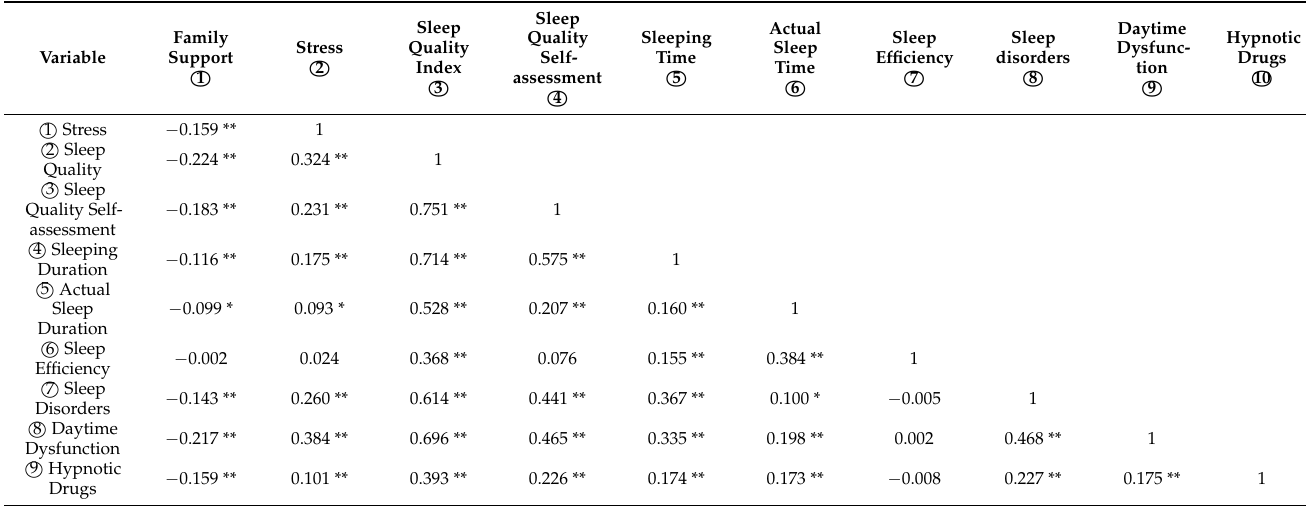
Table 2. Correlation analysis of family support, stress, and sleep quality.